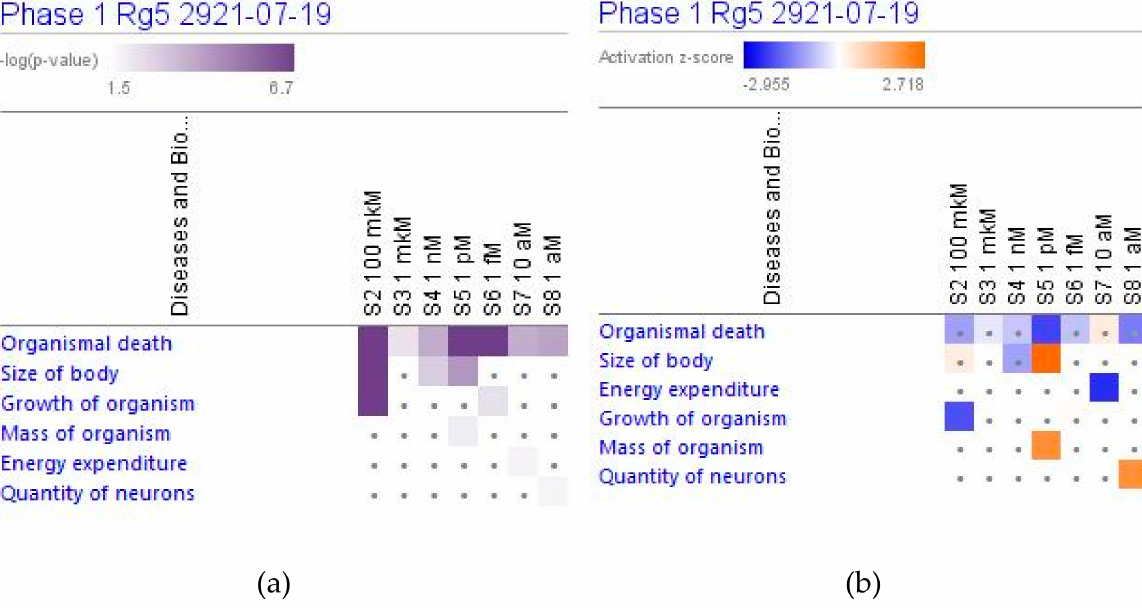
Figure 19. Effect of Rg5 at concentrations of 1 aM, 10 aM, 1 fM, 1 pM, 1 nM, 1 µ M and 100 µ M) on physiological functions, including organismal death. ( a ) The brown color shows the predicted activation, blue color the predicted inhibition of signaling pathway; the symbol shows that the activation z-score was <2. ( b ) The symbol shows that the − log p -value was